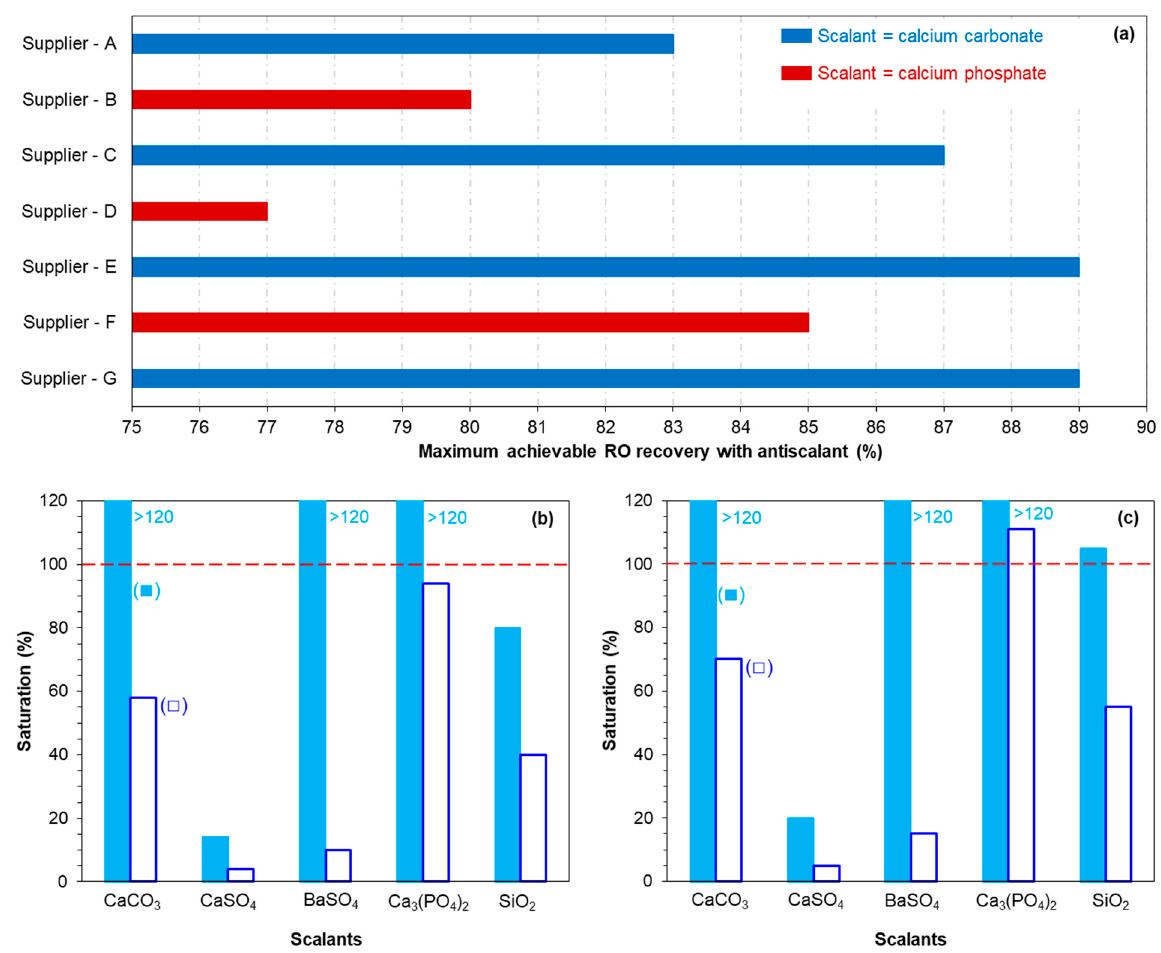
Figure 3. ( a ) Maximum achievable recovery of the RO unit in the presence of antiscalants deter- mined with the projection programs of various antiscalant suppliers. ( b ) Scaling potential of com- monly encountered scalants at 80% recovery of the RO unit ( ■ ) in the absence of antiscalant, and ( □ ) in the presence of antiscalant. ( c ) Scaling potential of commonly encountered scalants at 85% recov- ery of the RO unit ( ■ ) in the absence of antiscalant, and ( □ ) in the presence of antiscalant. ( b , c ) are determined with the projection program of supplier